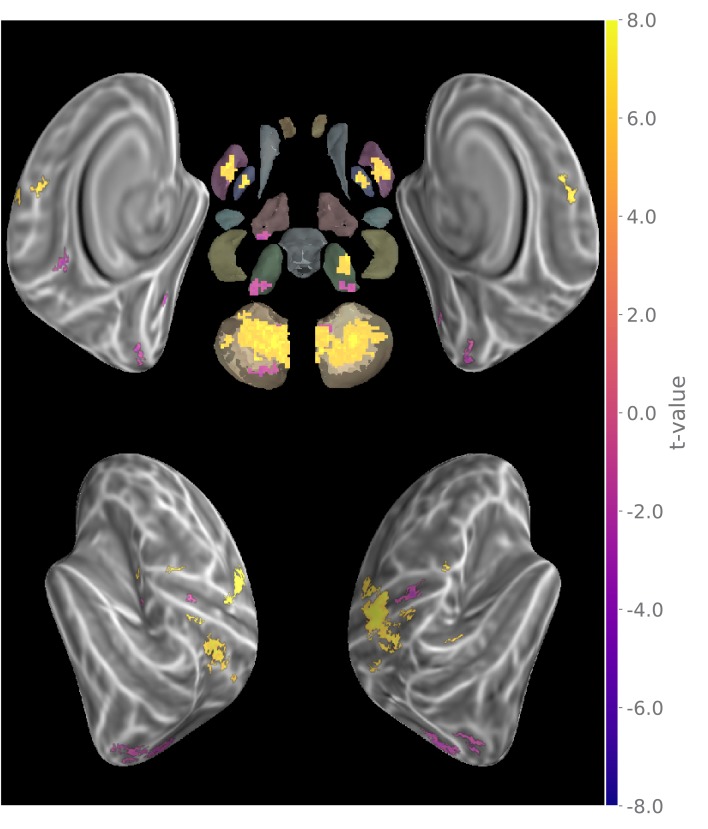
Main effect of motor sequence execution during MVPA task.(t-value thresholded at p < 05 FDR-corrected).